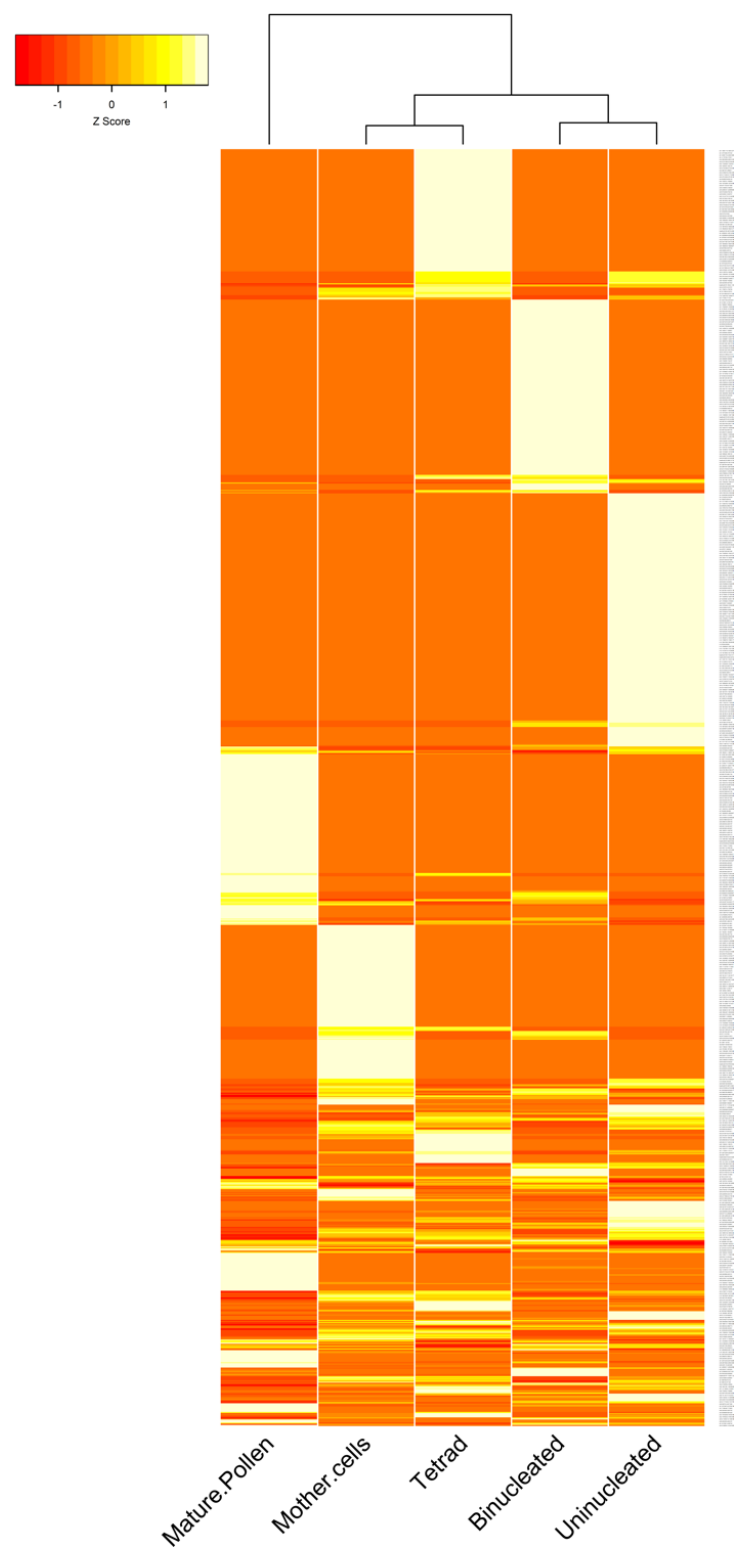
Figure 3. A heatmap showing the expression of 1180 identified circRNAs during pollen development in B. rapa.